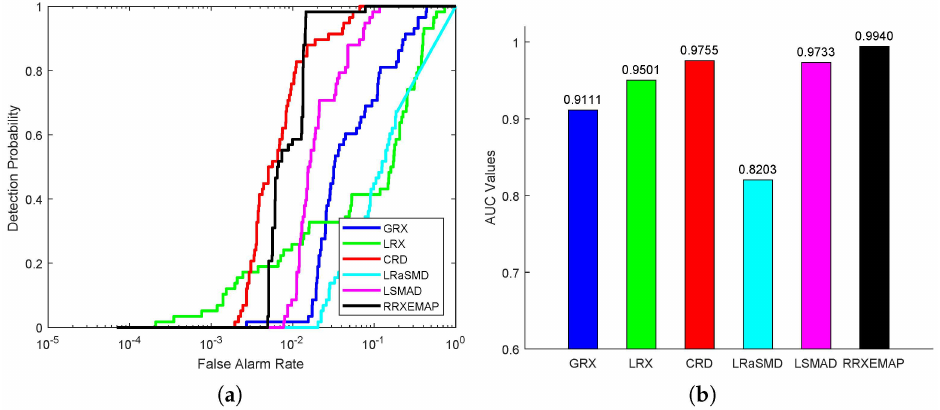
Figure 7. Detection accuracy evaluation for the AVIRIS-I dataset. ( a ) ROC curves. ( b ) AUC